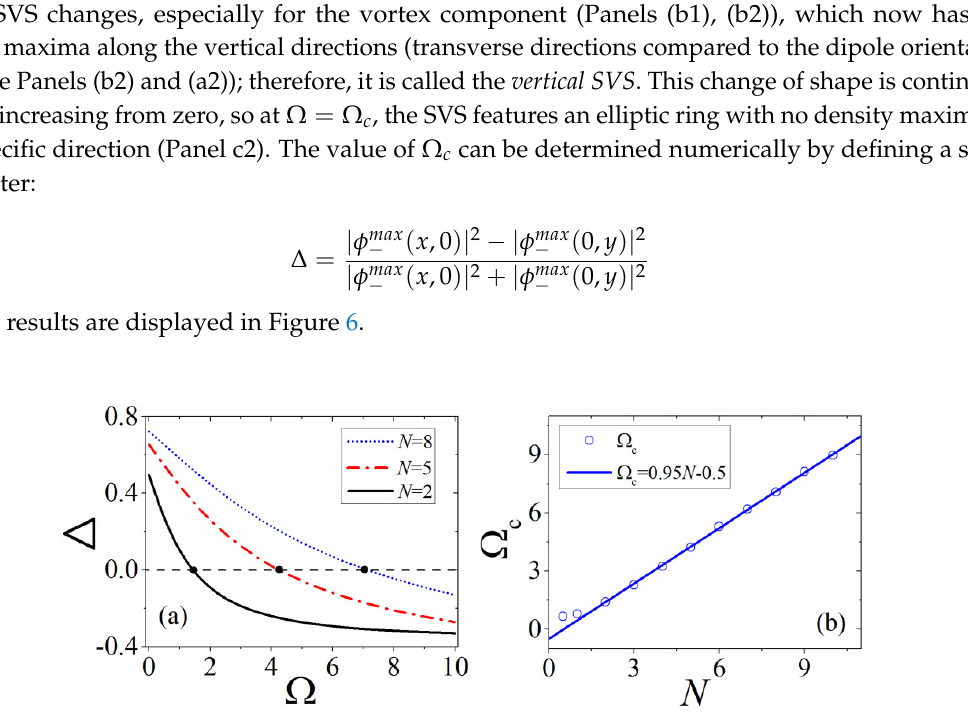
FIG. 2. (a) The shape parameter , defined as per Eq. (10), vs Figure 6. Shape change of the SVS controlled by the Zeeman splitting Ω . ( a ) Shape parameter ∆ versus Ω with different N ; the dashed line determines Ω c . ( b ) (Almost) linear relationship between N